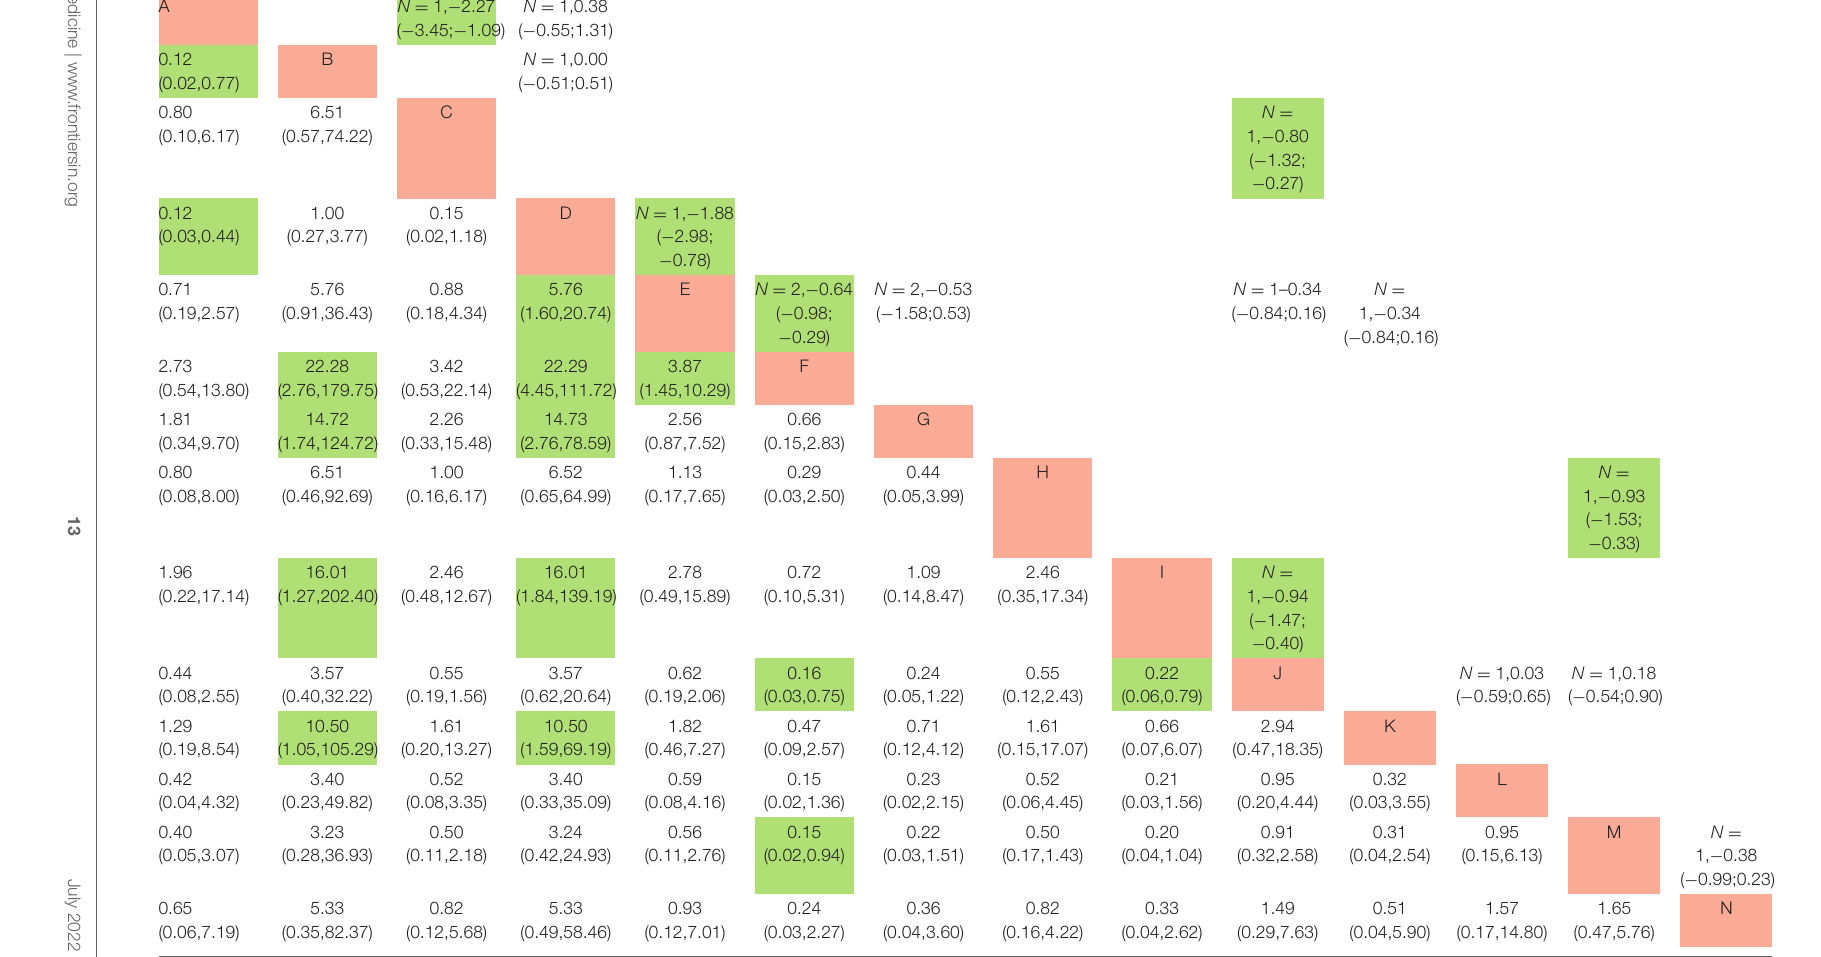
1. Lower-left triangle presents the findings (MD with 95%CI) of the network meta-analysis conducted using Stata 15.1. Upper-right triangle presents the findings (SMD with 95% CI) of the pair-wise meta-analyses conducted using STATA 15.1 and N refers to the numbers of RCTs which compared the 2 interventions directly. 3. A positive MD favors the lower-right intervention; a negative MD favors the upper-left intervention. 4. Statistically significant findings are shaded. A, CEB (cervical epidural block); B, EA (external application); C, HTESPB (high thoracic erector spinae plane block); D, IAI (intra-articular injection); E, INB (interscalene nerve block); F, INB + IAI (interscalene nerve block + intra-articular injection); G, INB + IVA (interscalene nerve block + intravenous administration); H, INB + SSNB (interscalene nerve block + suprascapular nerve block); I, OA (oral administration); J, PL (placebo); K, SCNB (supraclavicular nerve block); L, SGB (stellate ganglion block); M, SSNB (suprascapular nerve block); N, SSNB + ANB (suprascapular nerve block + axillary nerve block). Red represents the code of intervention measures and green represents the significant difference between two intervention measures with statistical